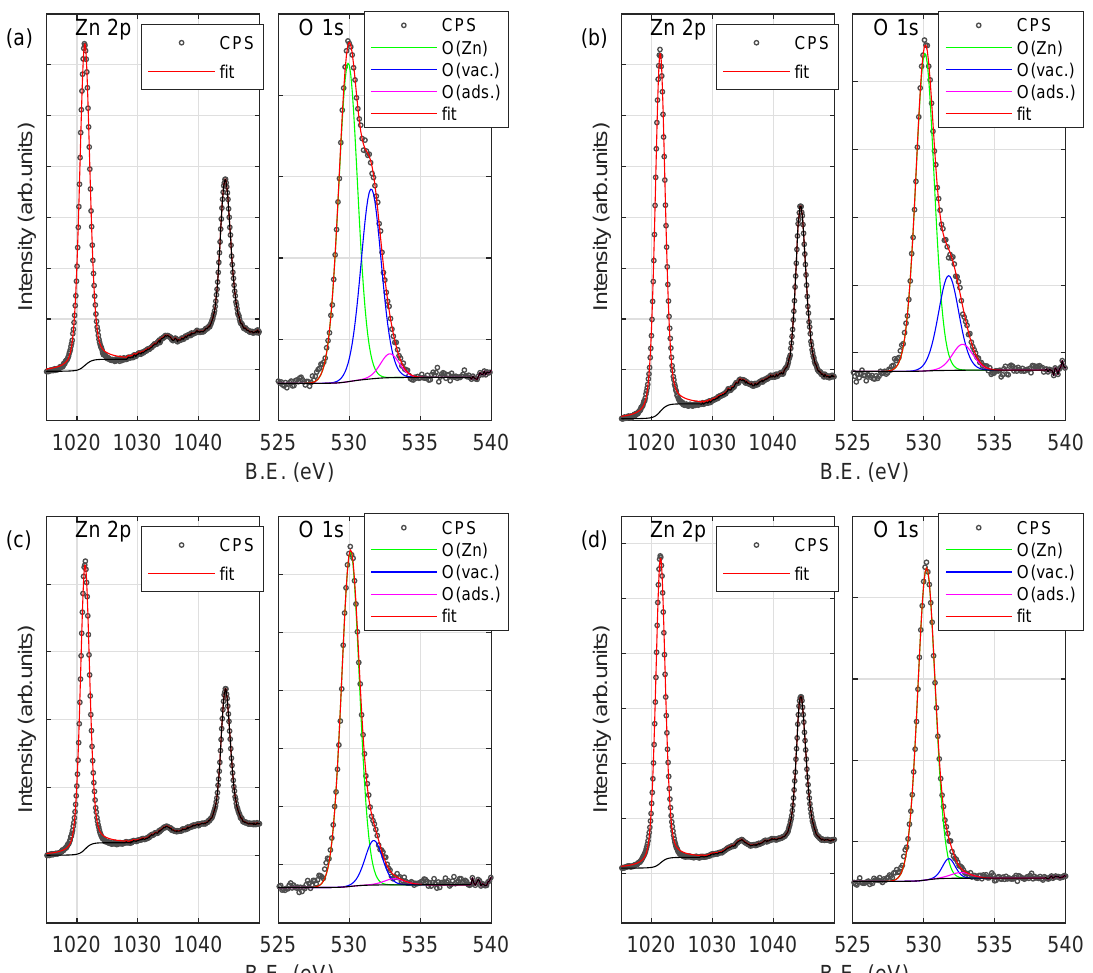
Figure 5. X-ray photoelectron spectroscopy (XPS) spectra (Zn 2p and O 1s peaks) of the sample deposited at room temperature (RT): ( a ) non-annealed and annealed at ( b ) 300 ◦ C, ( c ) 500 ◦ C and ( d ) 800 ◦